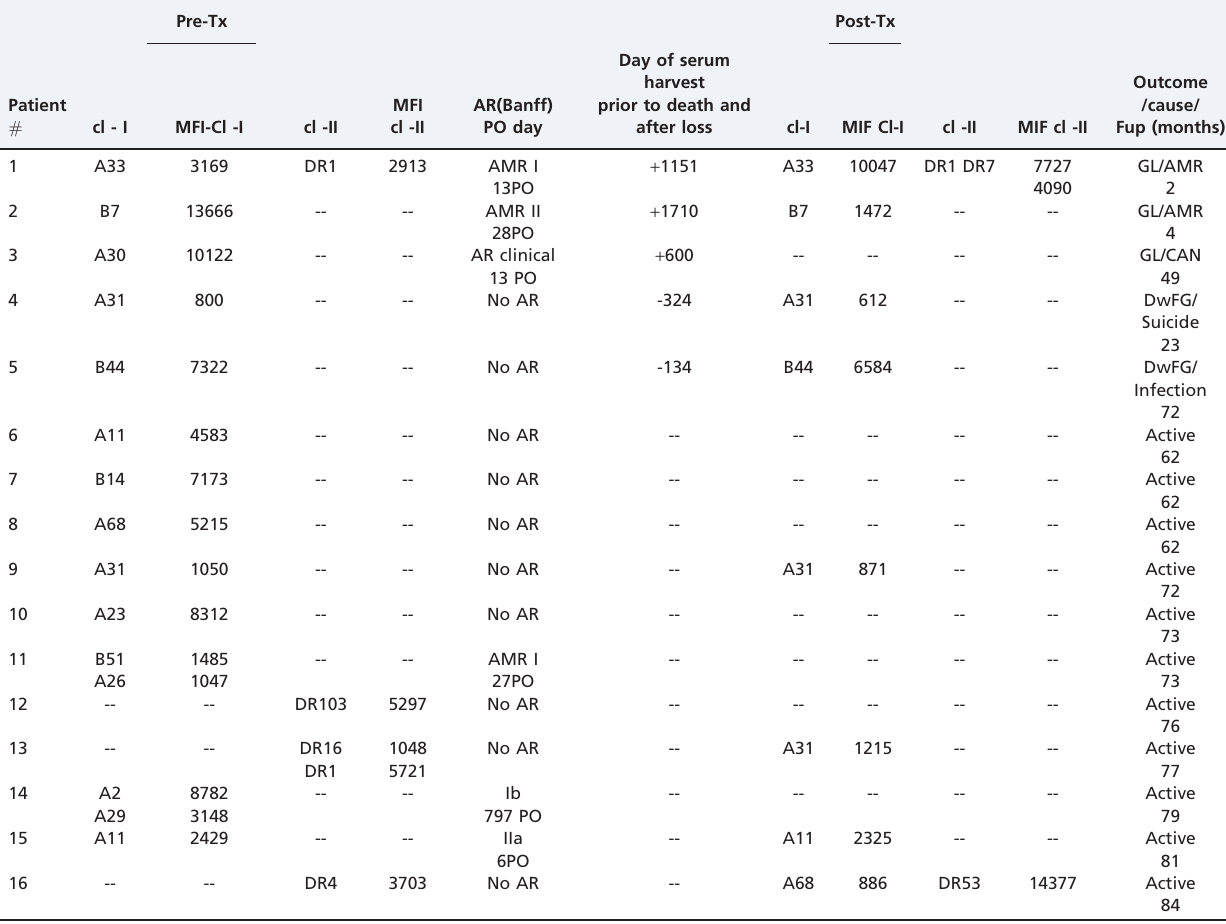
Table 2 - HLA-DSA and